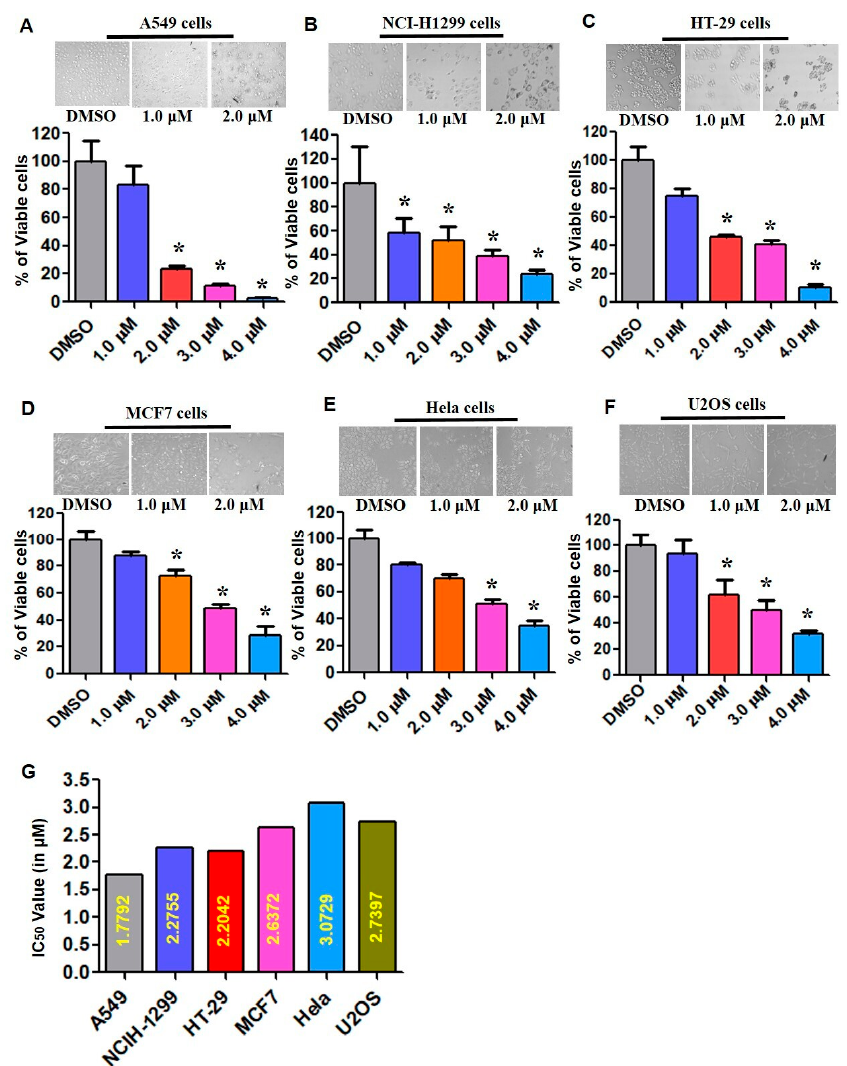
Figure 4. Tumoricidal activities of ECPU-0001 in numerous cell lines and colony forming inhibition. ( A ) Cellular cytotoxicity assay performed in A549. ( B ) NCI-H1299. ( C ) HT-29 ( D ) MCF7, ( E ) Hela, and ( F ) U2OS cancer cell lines. Approximately 0.5 × 10 6 cells/well were seeded in 60 mm cell culture plates and treated with ECPU-0001 1.0, 2.0, 3.0, and 4.0 µM/mL for 24 h; 0.2% dimethylsulfoxide (DMSO) in medium was used as a control. ( G ) IC 50 values for different types of cancer cell lines using the cell cytotoxicity assay. Magnification Scale bar: 20×. *: p < 0.05.